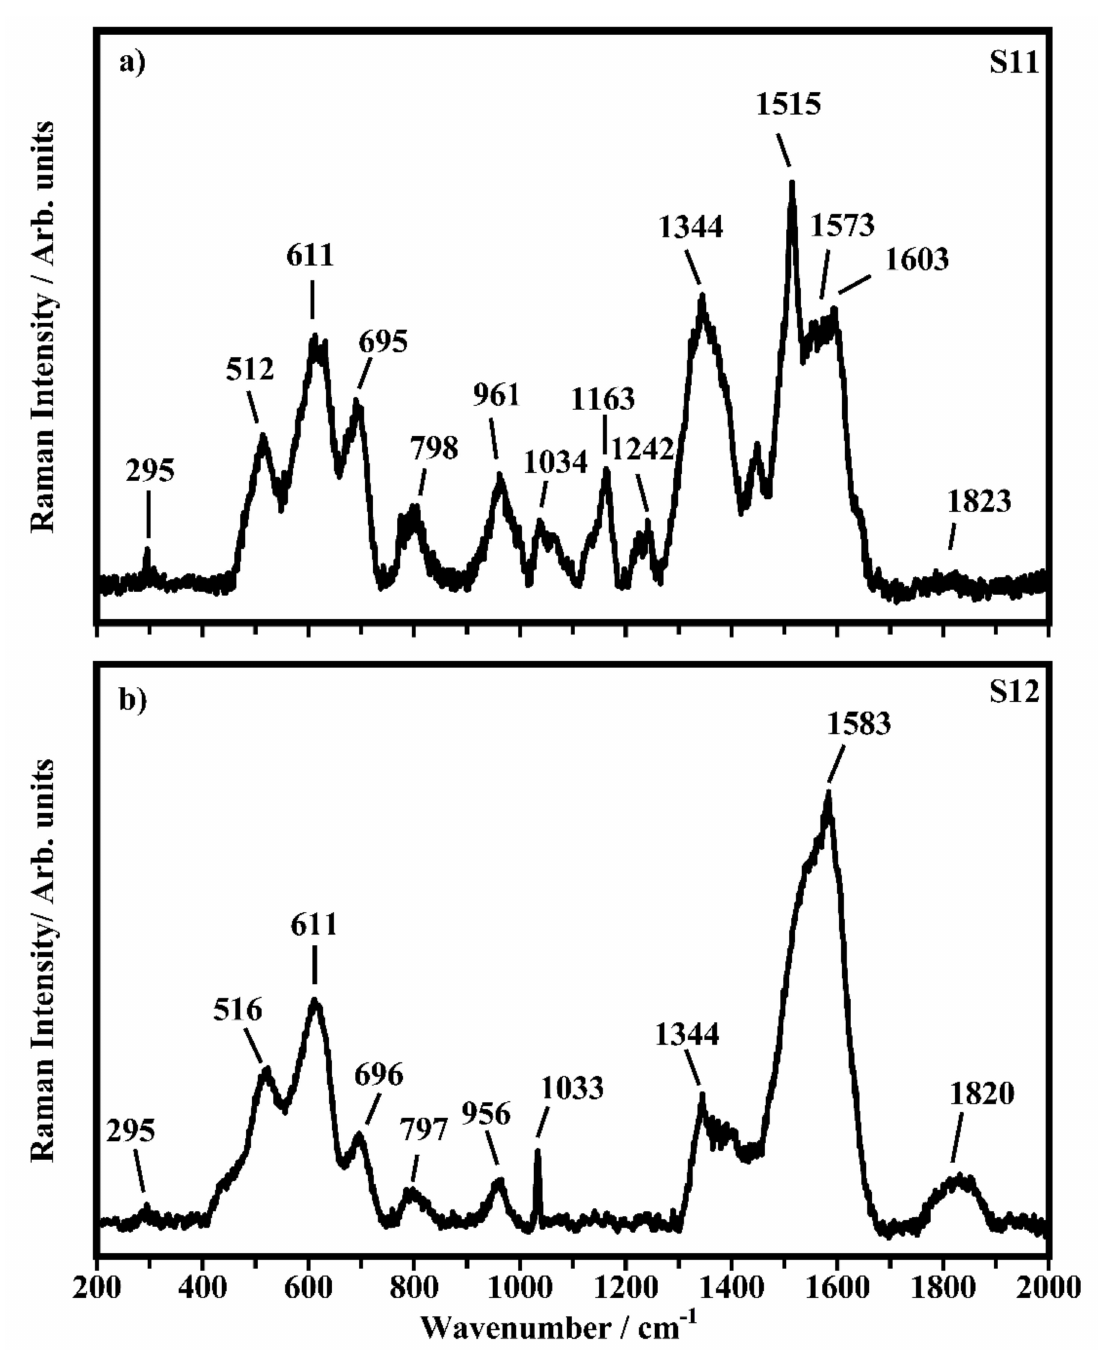
Figure 5. Representative Raman spectra collected on the sectors S11 (spectrum ( a )) and S12 (spectrum ( b )) of the specimen N. 01.1622_fragment and by using a laser source at